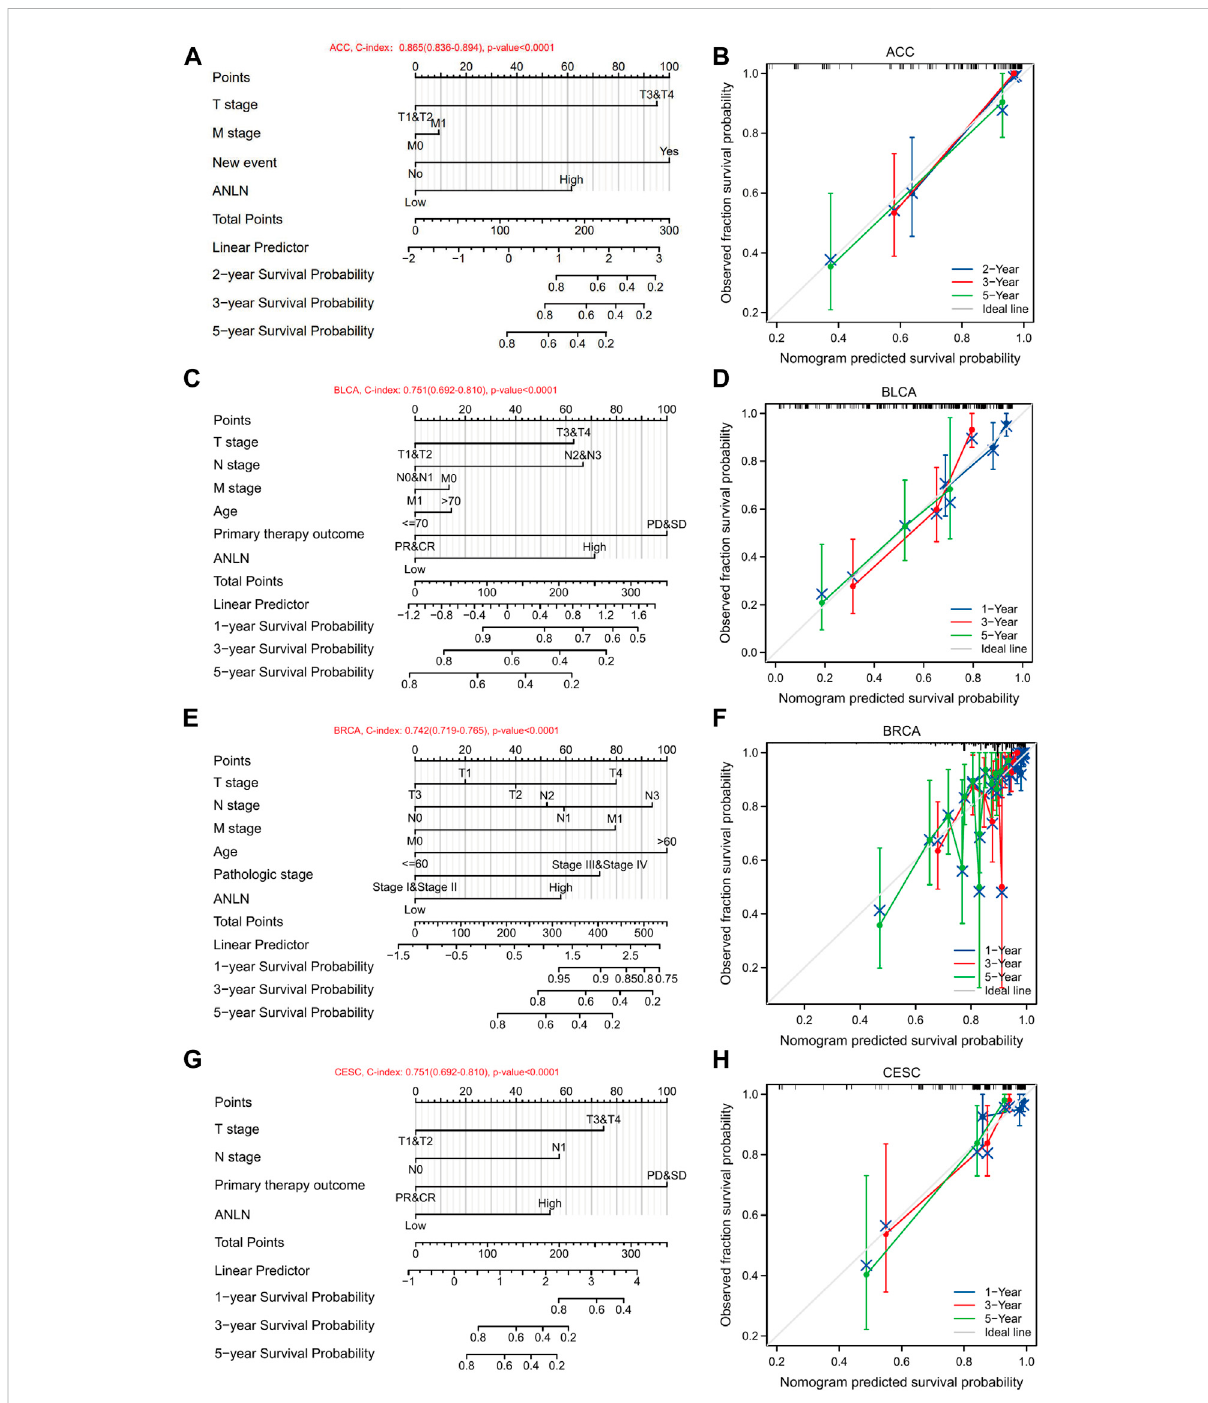
FIGURE 13 NomogramsandcalibrationcurvespredictingpatientOSin7cancers.NomogramsofACC (A) ;BLCA (C) ;BRCA (E) ;CESC (G) .Calibrationcurves ofACC (B) ;BLCA (D) ;BRCA (F) ;CESC (H) .The horizontal andvertical coordinatesare themodelpredicted andactuallyobserved survival probability, respectively. The closer each line is to the ideal line, the better the